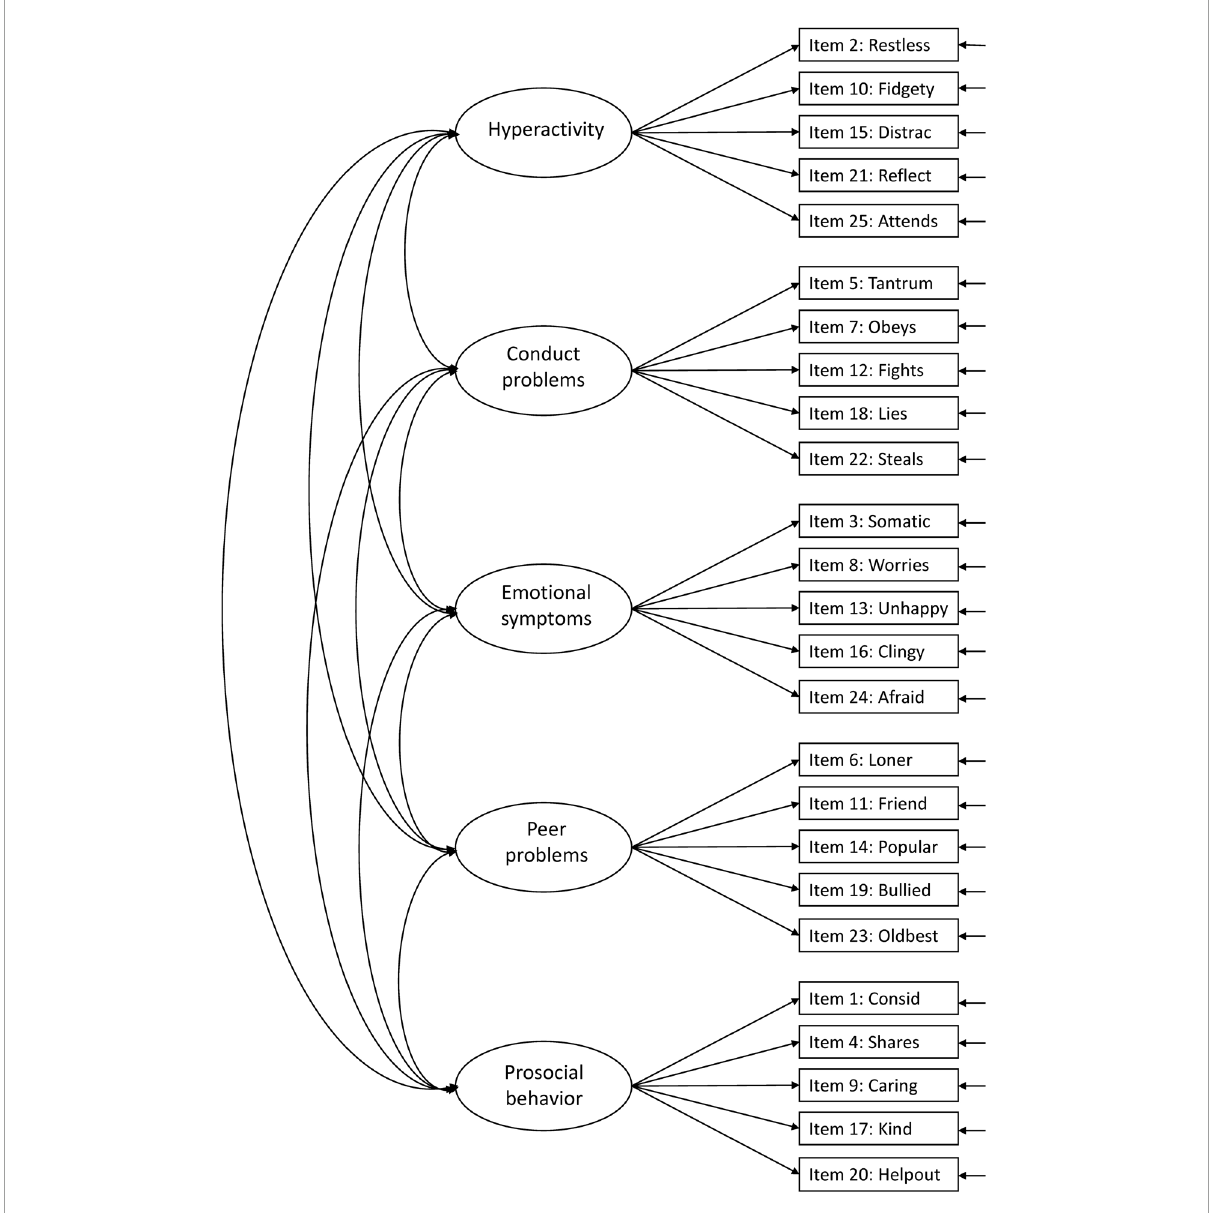
FIGURE1 Original five-factor structure (Model